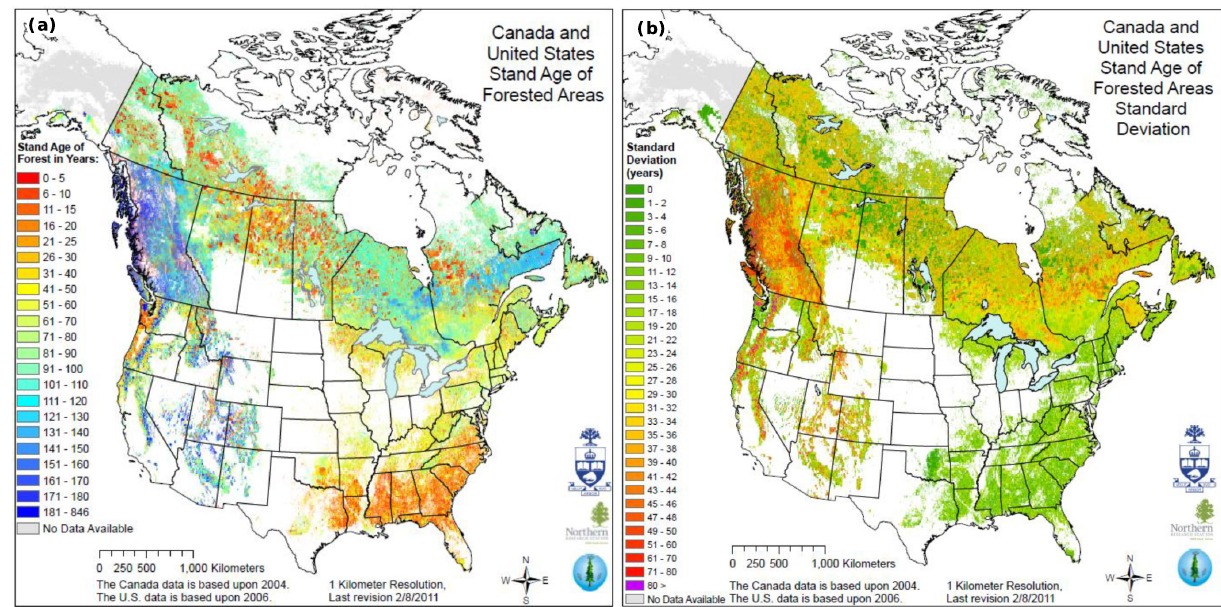
Fig. 1. (a) Forest age distribution in North America (excluding Alaska and Mexico), which was developed by combining forest inventory data (of US and Canada) with several remote sensing based disturbance data sources. (b) The standard deviations of forest ages that characterize uncertainty in the age map (a)